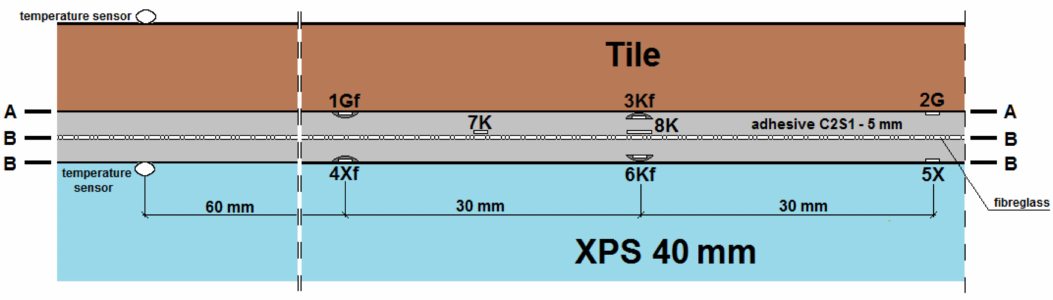
Figure 6. A and B vertical section of the research model with C2S1 adhesive, without lamellas.